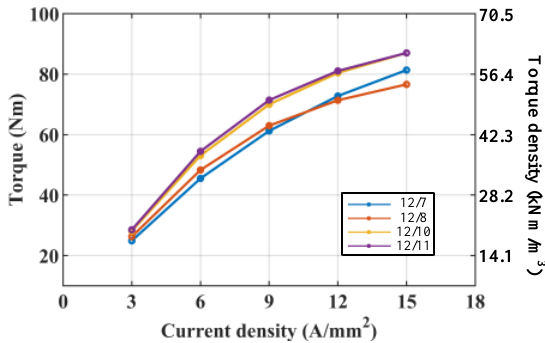
Figure 10. The curve of current density vs. torque and torque density.